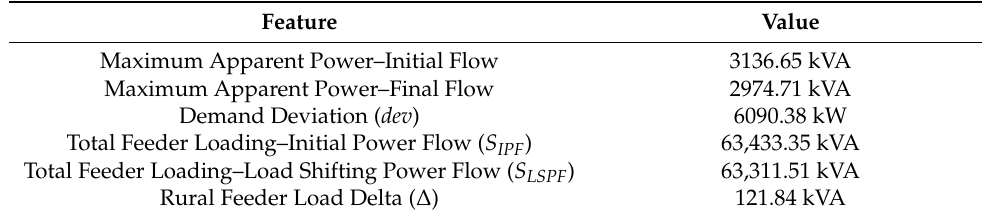
Table 9. Summary on the application of the load shifting strategy on Rural Feeder C. Source: The authors.